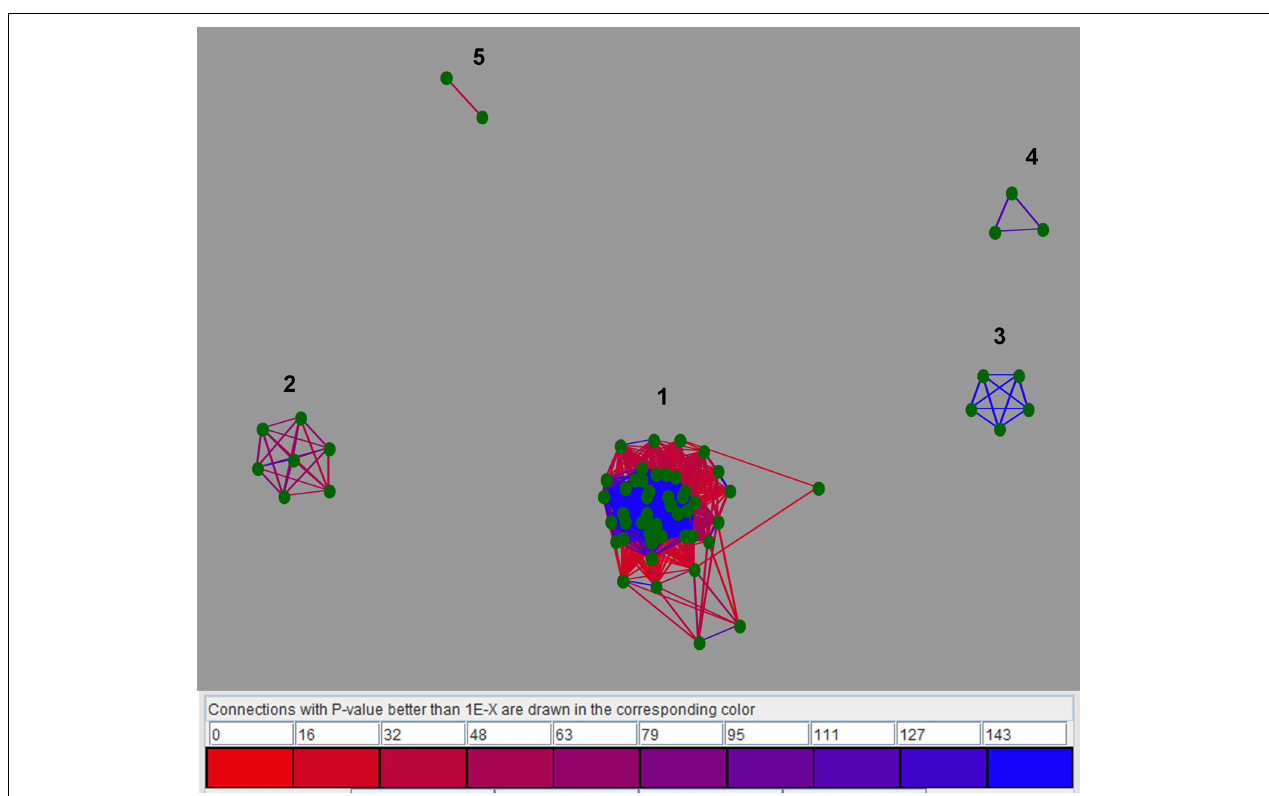
FIGURE 4 | Two-dimensional CLANS clustering of LuxR solos. CLANS analysis was carried out on the representative 657 LuxR solo sequences as detailed in materials and methods. LuxR solos that clustered are represented